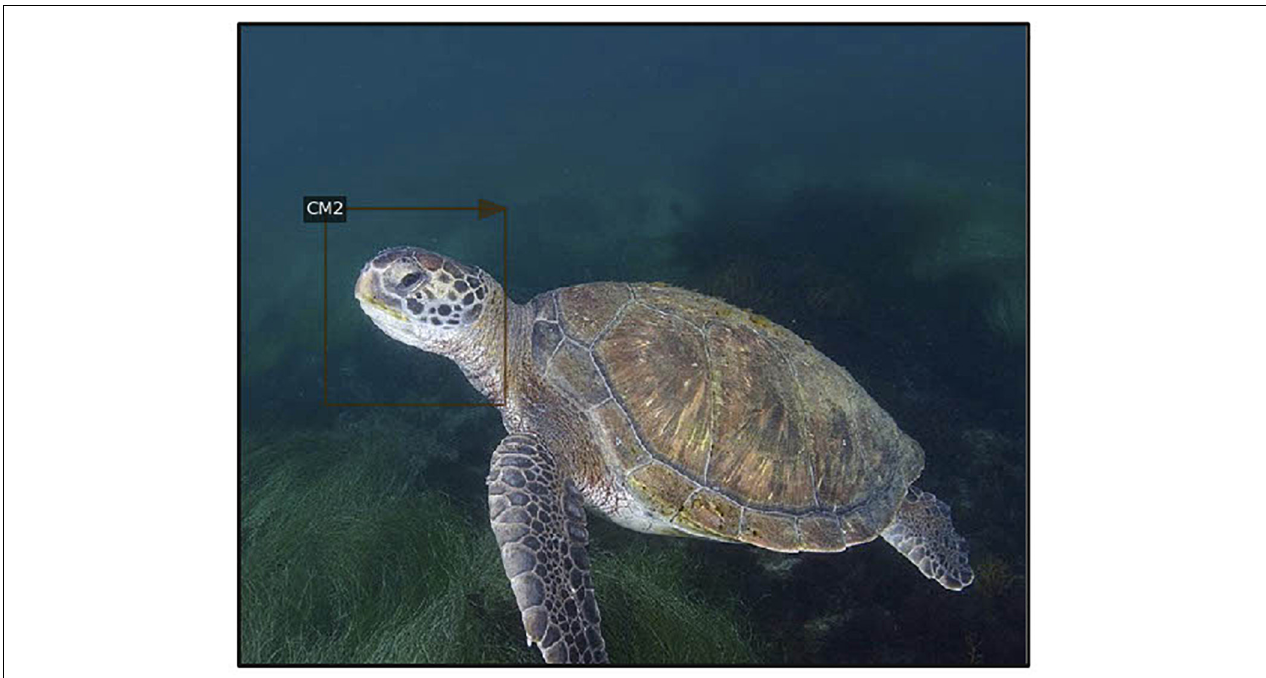
FIGURE 2 | Demonstrates a “Chip” manually placed on the image to encompass the left post-ocular scutes of individual CM2 using the Hotspotter software. Photo taken by Jami Leslie Feldman.